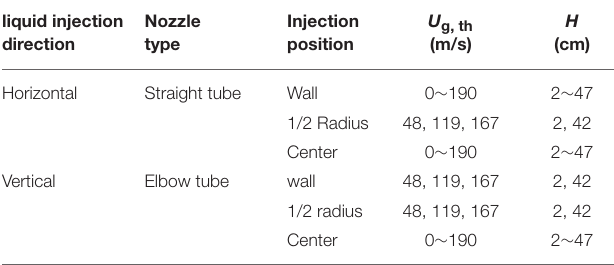
TABLE 1 | Experimental operating